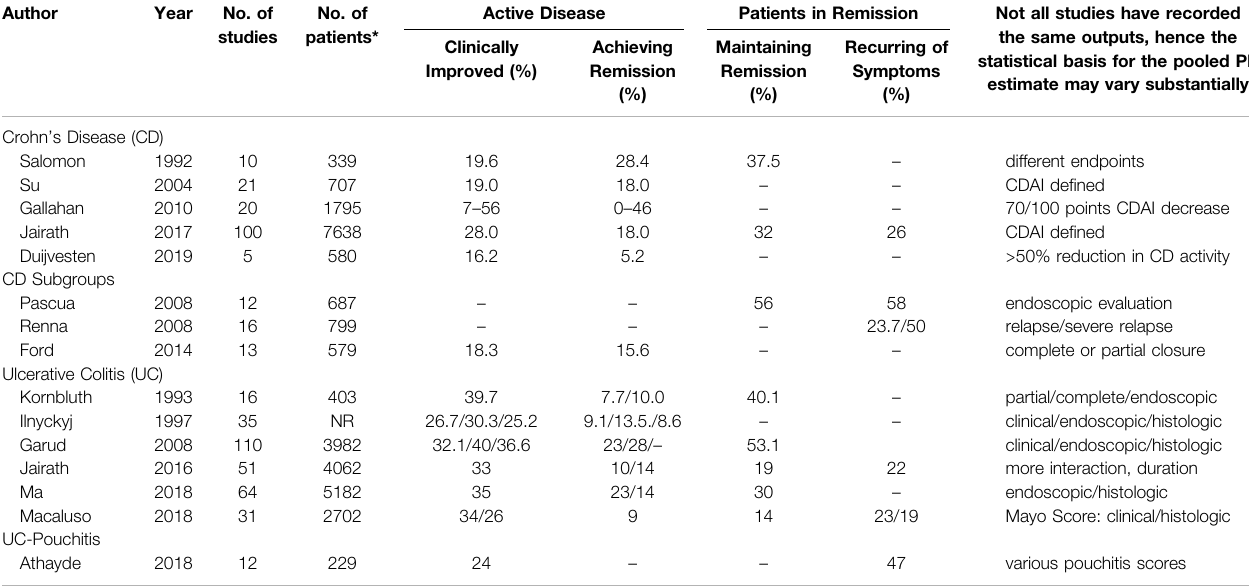
TABLE 1 | Pooled placebo responses (%) in randomized placebo-controlled trials according to different meta-analyses in Crohn´s Disease (CD), Ulcerative Colitis (UC) and pouchitis in patients with active disease or in remission (CDAI: Crohn´s Disease Activity